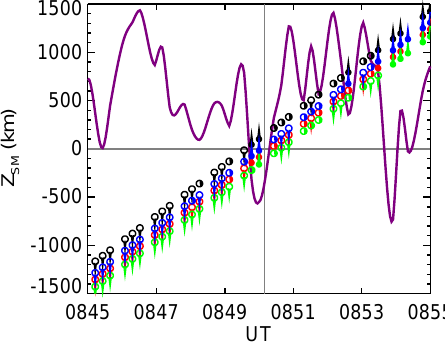
Fig. 6. Symbols represent variations of the sign of the parallel component of the Poynting flux of chorus along the orbit of the four Cluster spacecraft (black-C1, red-C2, green-C3, blue-C4) – empty symbols with downward arrows mean predominant South- ward propagation whereas solid symbols with upward arrows are used when chorus mainly propagates to the North. The half-solid symbols without arrow show data points where the sign of the par- allel component of the Poynting flux was uncertain. Each symbol at the same time represents the Z S M coordinate of the corresponding spacecraft as a function of time. The horizontal solid line shows the position of the magnetic equator; the vertical solid line shows the time when the center of mass of the four spacecraft crosses the equator. The purple line is the estimated central position of the cho- rus source region (Santol´ık et al., 2005).